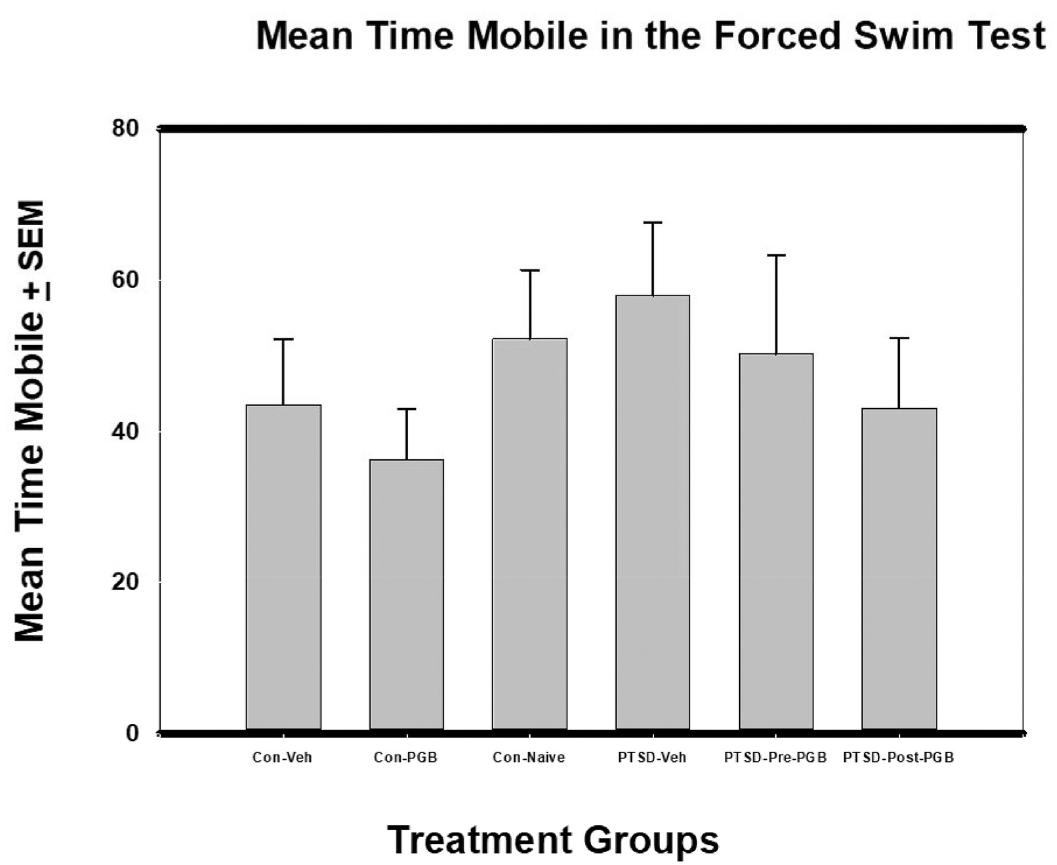
Fig 6. ANOVA of Mean Time Mobile from Forced Swim test (FST) and Standard Error of the Mean (SEM). Each of the main two groups (Stressed and Non-stressed) had three subgroups: non-stressed: control vehicle, control PGB, control na ï ve; and stressed: Posttraumatic stress disorder (PTSD) vehicle, PTSD Pre-PGB (prophylactic), PTSD Post-PGB (non-prophylactic). There was no significant difference between the six